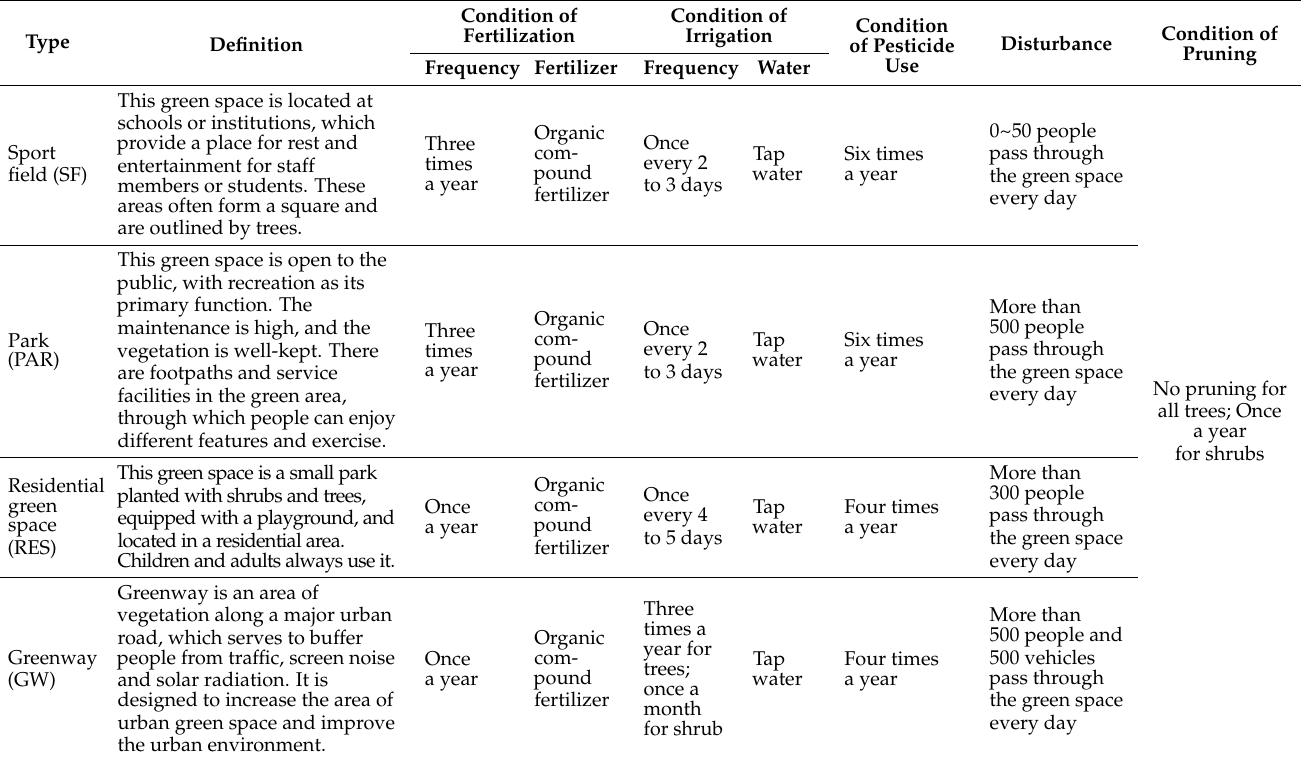
Table 1. Description and basis condition of each type of urban green space.